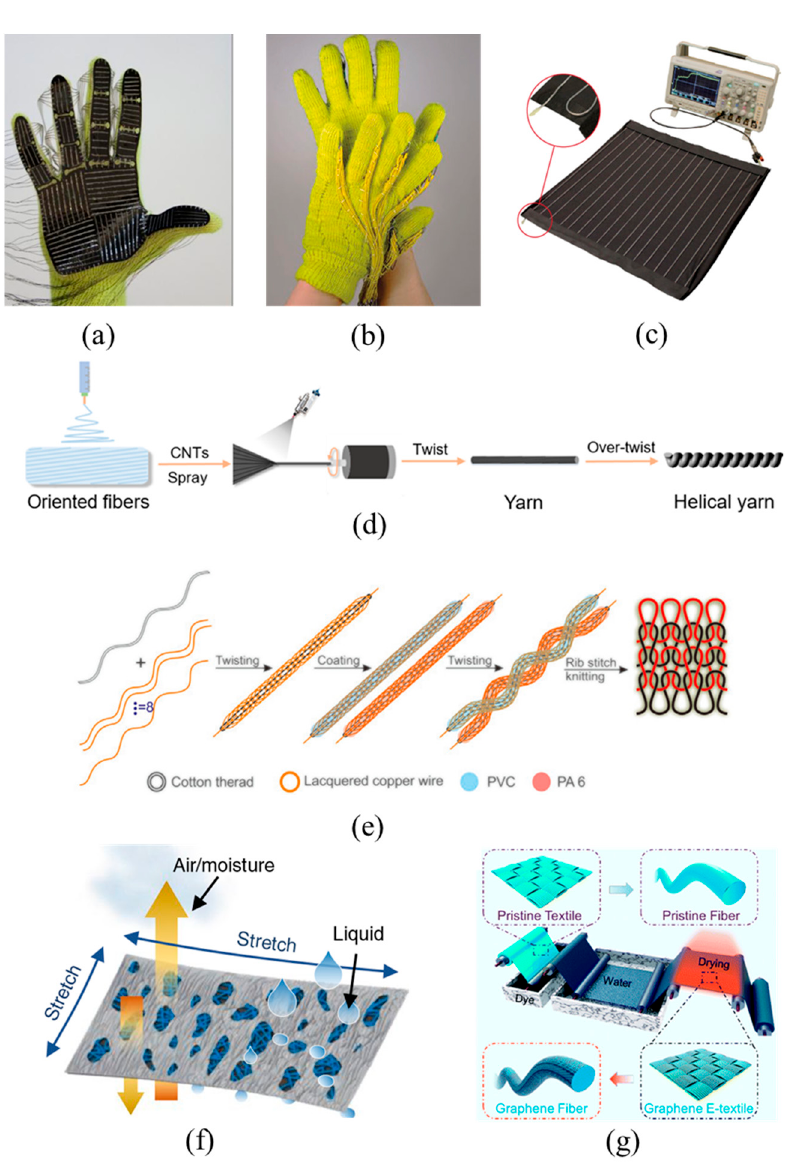
Figure 3. Advantages. CNTs means carbon nanotubes, PVC means poly vinyl chloride and PA6 means Polyamide 6 ( a ) large area array sensors based on piezoresistive film, reproduced with permission from [64]; ( b ) large area array sensors based on fibers, reproduced with permission from [65]; ( c ) large area detection mechanical stimulation using electrical time domain reflectometer, reproduced with permission from [66]; ( d ) large deformation sensors based on spiral structure, reproduced with permission from [68]; ( e ) large deformation sensors based on ribbed weave, reproduced with permission from [69]; ( f ) fabric sensors breathability based on pre-stretching, reproduced with permission from [72]; and ( g ) fabric sensors breathability based on coating shrinkage, reproduced with permission from ref. [73].